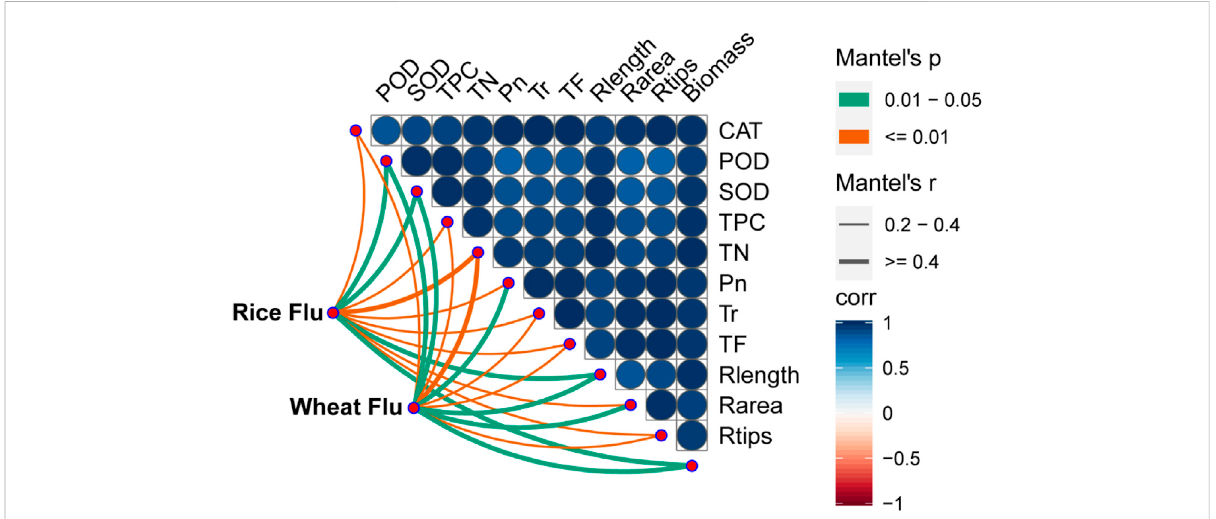
FIGURE 3 Parameters of plant drivers of the potentially fl uoranthene accumulation in rice and wheat. Association of the potential fl uoranthene accumulation (Bray-Curtis distance) and plant physicochemical properties were analyzed with Mantel tests. CAT: Catalase; POD: Peroxidase; SOD: Superoxide dismutase; TPC: Total protein content; TN: Total nitrogen; Pn: Photosynthesis; Tr: Transpiration; TF: Transfer coef fi cient; Rlength: Root length; Rarea: Root area; Rtips: Root tips. The edge width corresponds to the R value, and edge color denotes the statistical signi fi cance. The color gradient indicates Pearson correlation coef fi cients among the plant physicochemical properties and indicates no signi fi cant correlation at 0.05